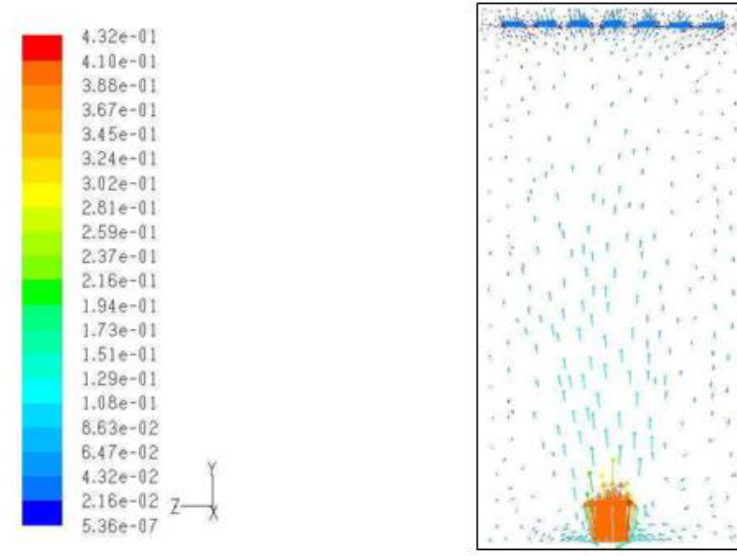
Figure 7. Velocity distribution on sub-channel with cylindrical longitude arrangement on forced convection for laminar flow regime under distributor wall.